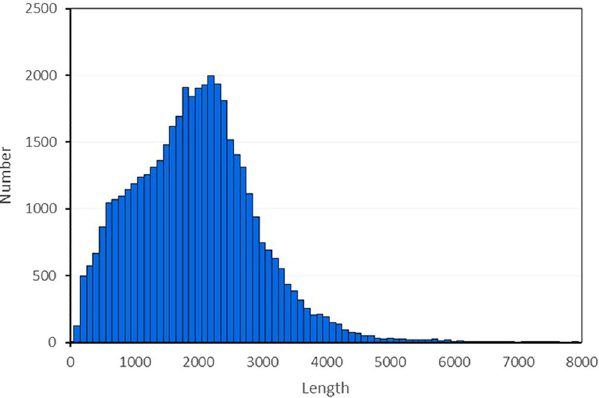
Figure 2. Length distribution of A. sinensis transcripts generated by single-molecule long-read sequencing.